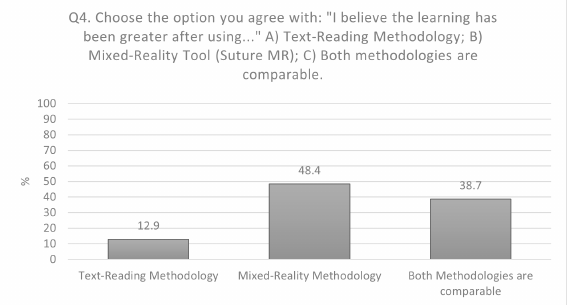
Figure 8. Results of Question 4 of Users Subjective Evaluation Questionnaire: users subjective appreciation of greater learning for both methodologies.